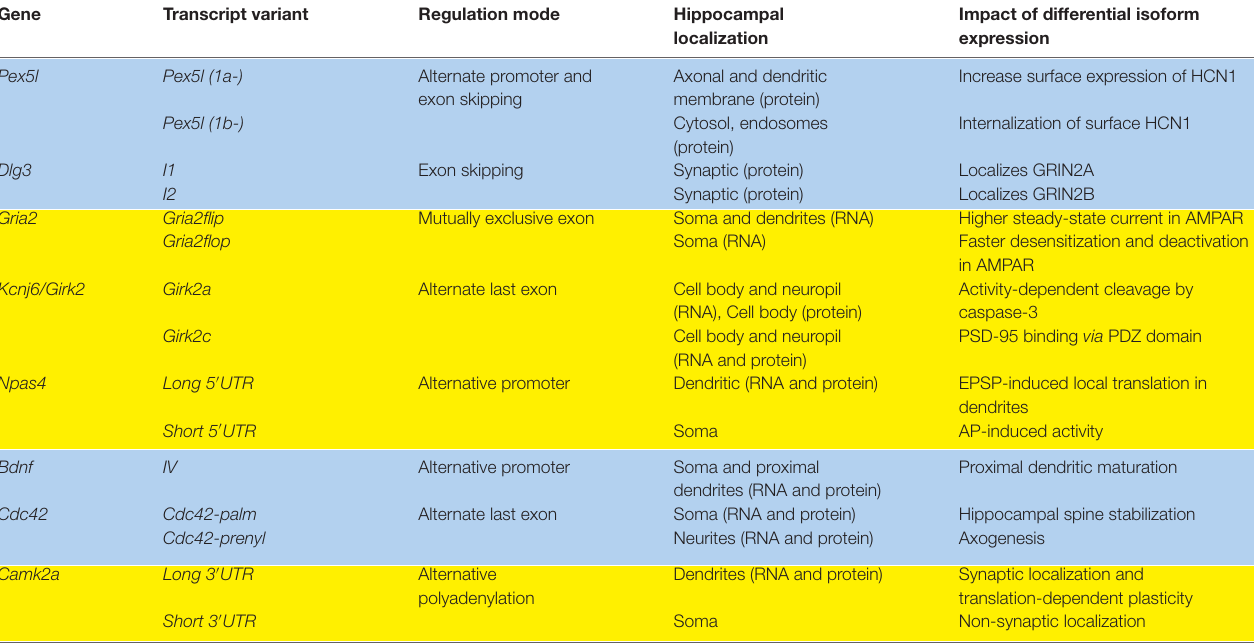
TABLE 1 | Summary of transcript isoforms discussed in this